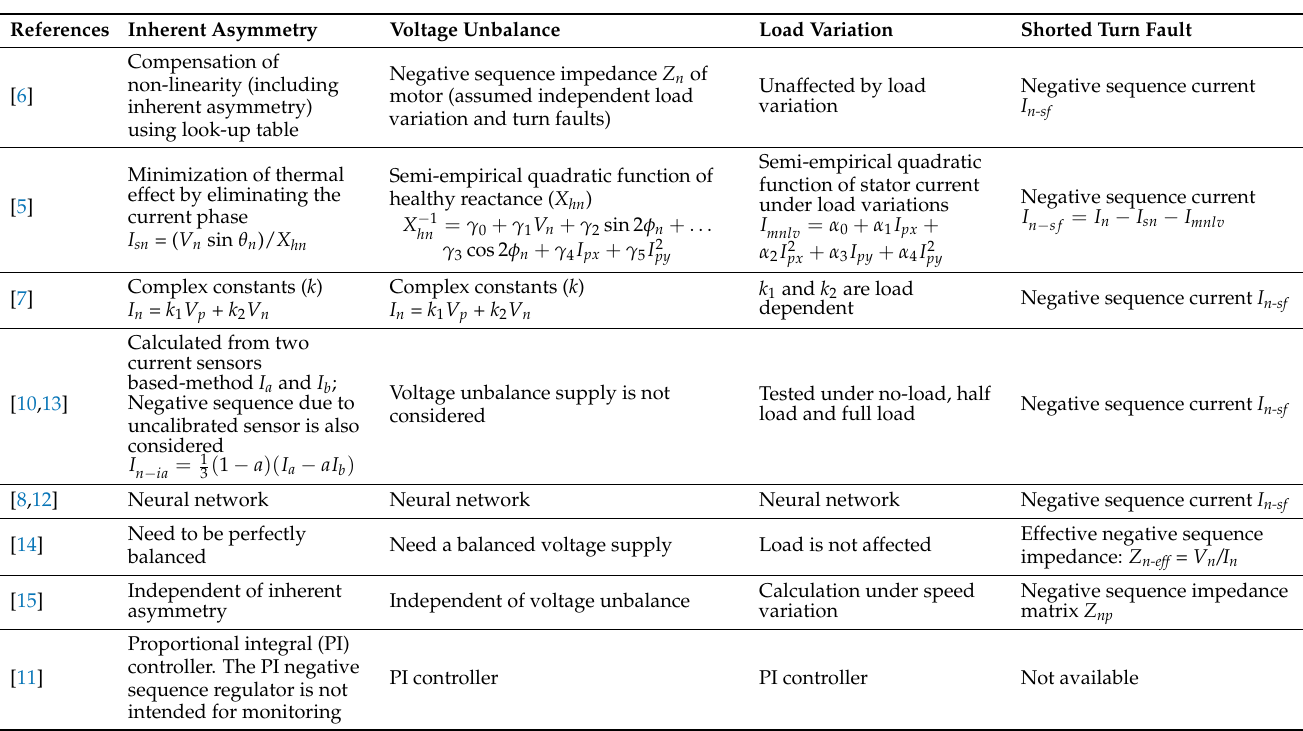
Table 1. Features of Negative Sequence Current Compensation Techniques Reported in the